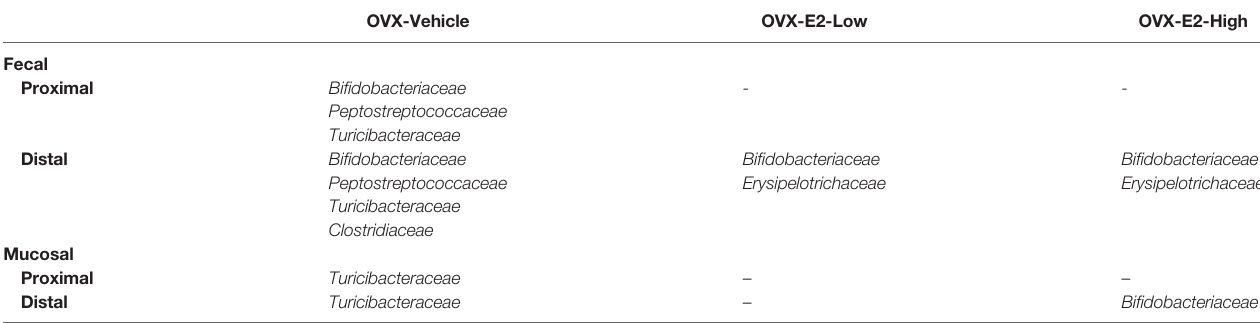
a Group abbreviation (e.g., Sham-Vehicle) are described in Table 1 .